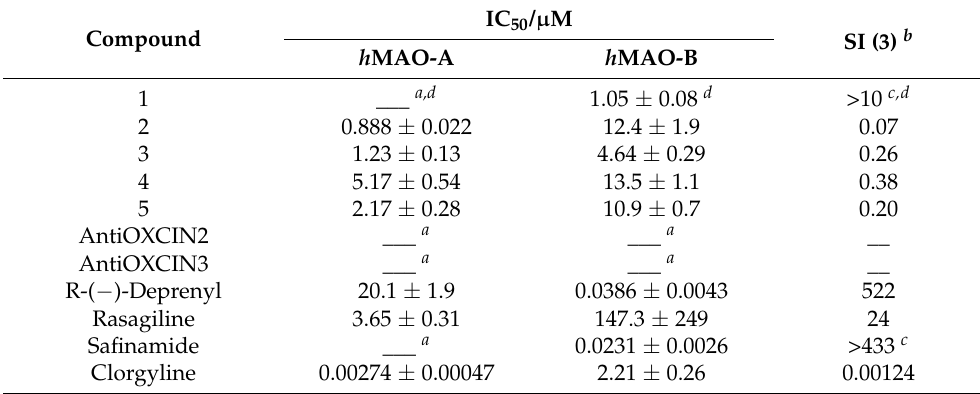
Table 3. Evaluation of h MAOs ( h MAO-A and h MAO-B) inhibitory activity of piperine (compound 1), compounds 2–5, AntiOXCIN2, AntiOXCIN3 and reference